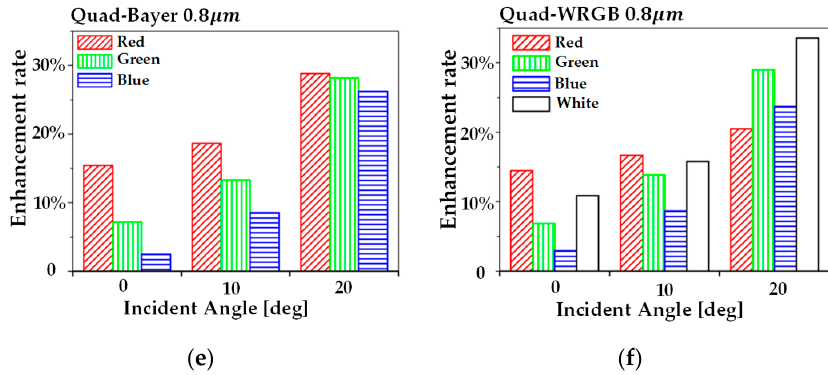
Figure 5. Enhancement rates of the photon density between the DTI/WG and the S-DTI/S-WG at incident angles of 0°, 10°, and 20°. The red oblique striped bar, the green vertical striped bar, the blue horizontal striped bar, and the blank bar indicate the enhancement rates in the red, green, blue, and white pixels, respectively: ( a ) quad-Bayer CFA for the 1.0 μ m pixel, ( b ) quad-WRGB for the 1.0 μ m pixel, ( c ) quad-Bayer CFA for the 0.9 μ m pixel, ( d ) quad-WRGB for the 0.9 μ m pixel, ( e ) quad-Bayer CFA for the 0.8 μ m pixel, ( f ) quad-WRGB for the 0.8 μ m pixel.